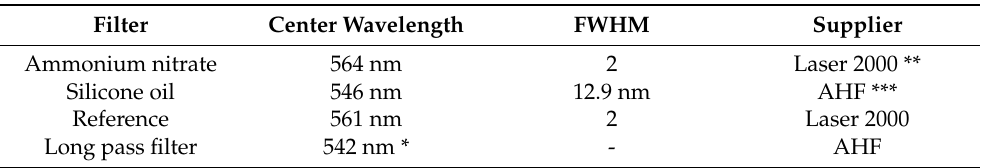
Table A1. Details regarding the optical filters. * Edge wavelength. ** Laser 2000, Wessling, Germany.